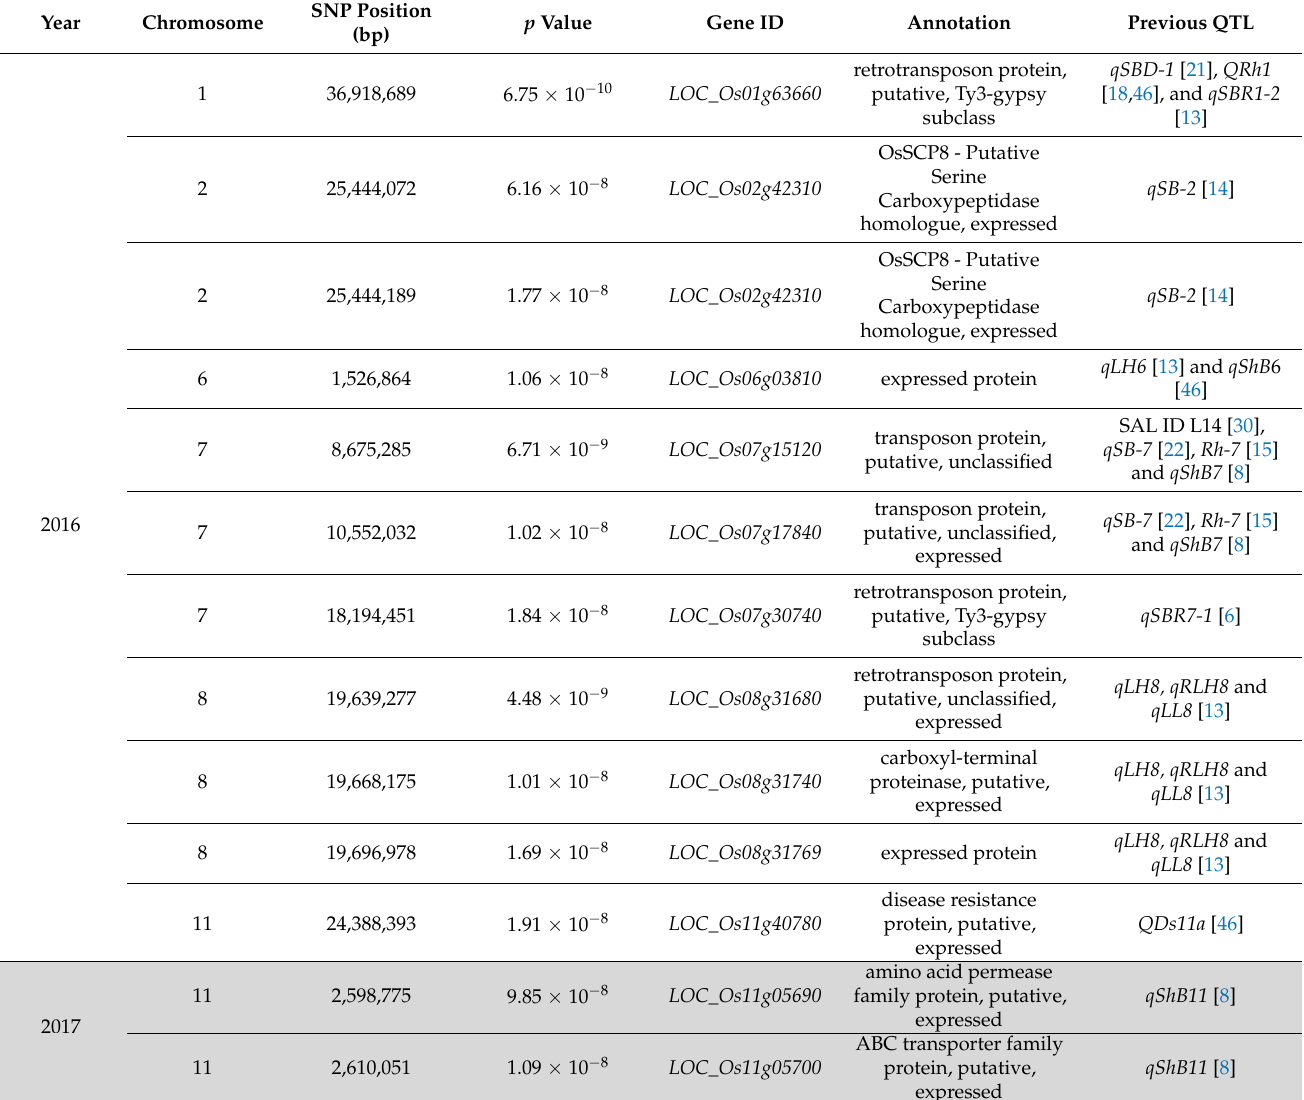
Table 2. List of significant gene-based SNPs for sheath blast resistance using EMMAX.